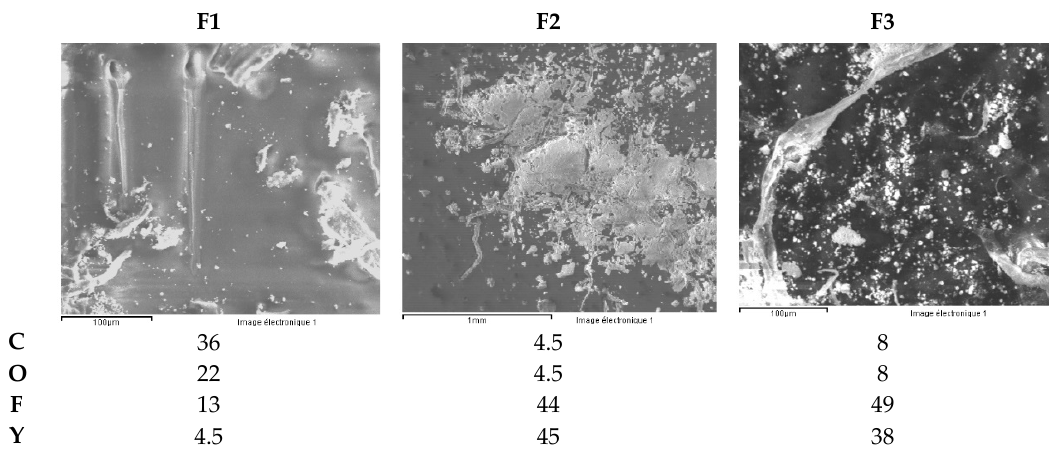
Figure 25. SEM analysis of the precipitates [ %m/m ] .